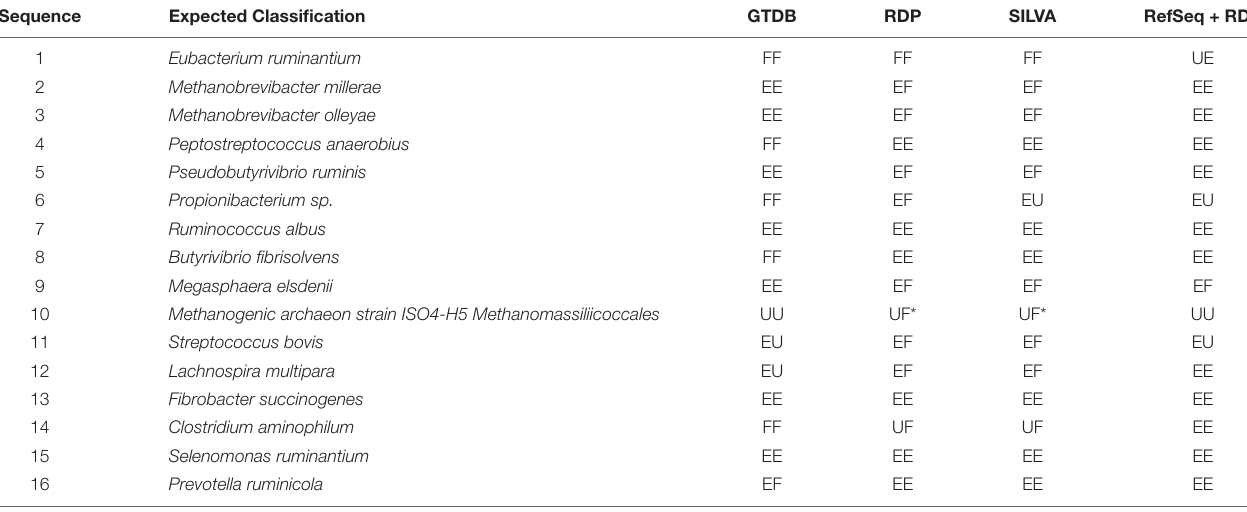
TABLE 2 | Expected vs. actual classification of bacterial ( n = 13) and archaeal ( n = 3) sequences included in reference standard by four databases at a bootstrapping threshold of 50. Sequence